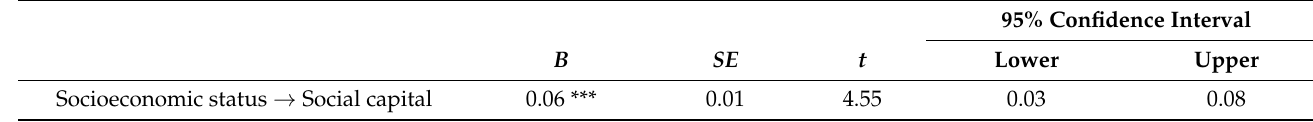
Table 5. Direct effect of socioeconomic status on Social capital.